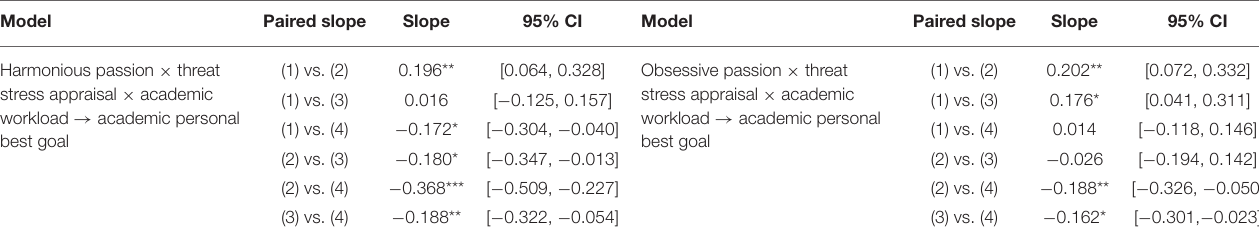
TABLE 3 | The significance test of slope